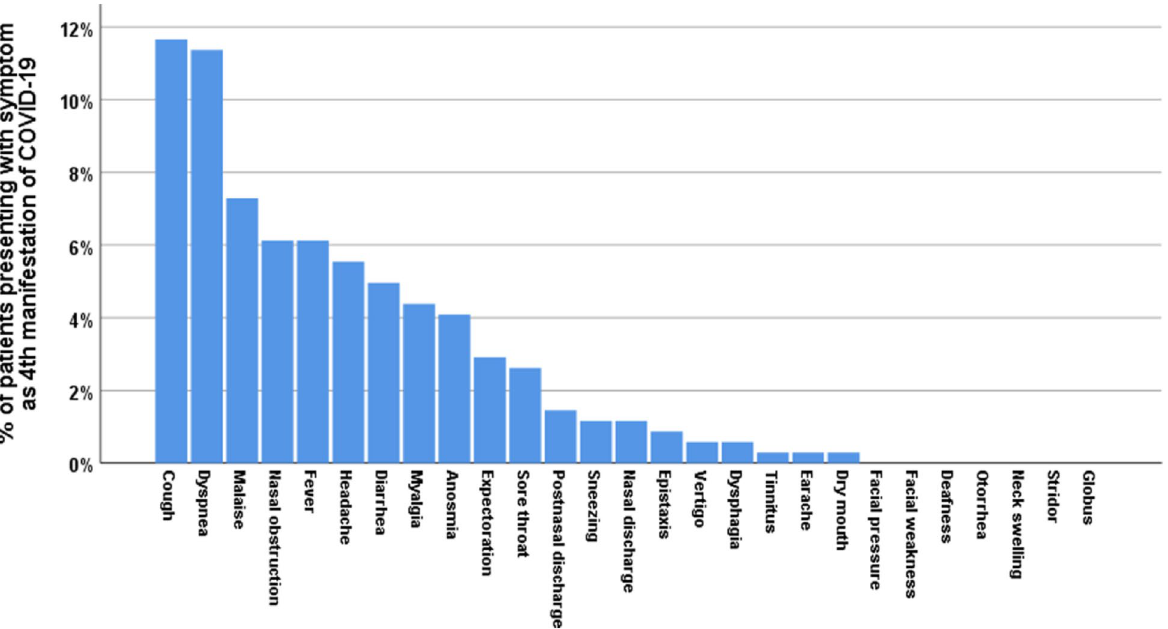
Fig. 5 Percentage of patients presenting with various symptoms (ORL, non-ORL) as fourth manifestation of